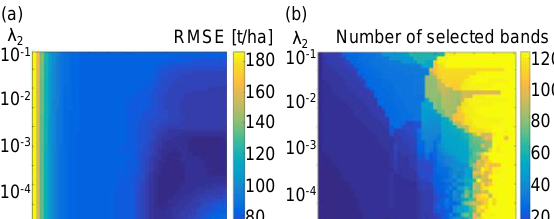
Figure 5. Accumulated selected number of each band by the lasso regression in 50 times cross-validation